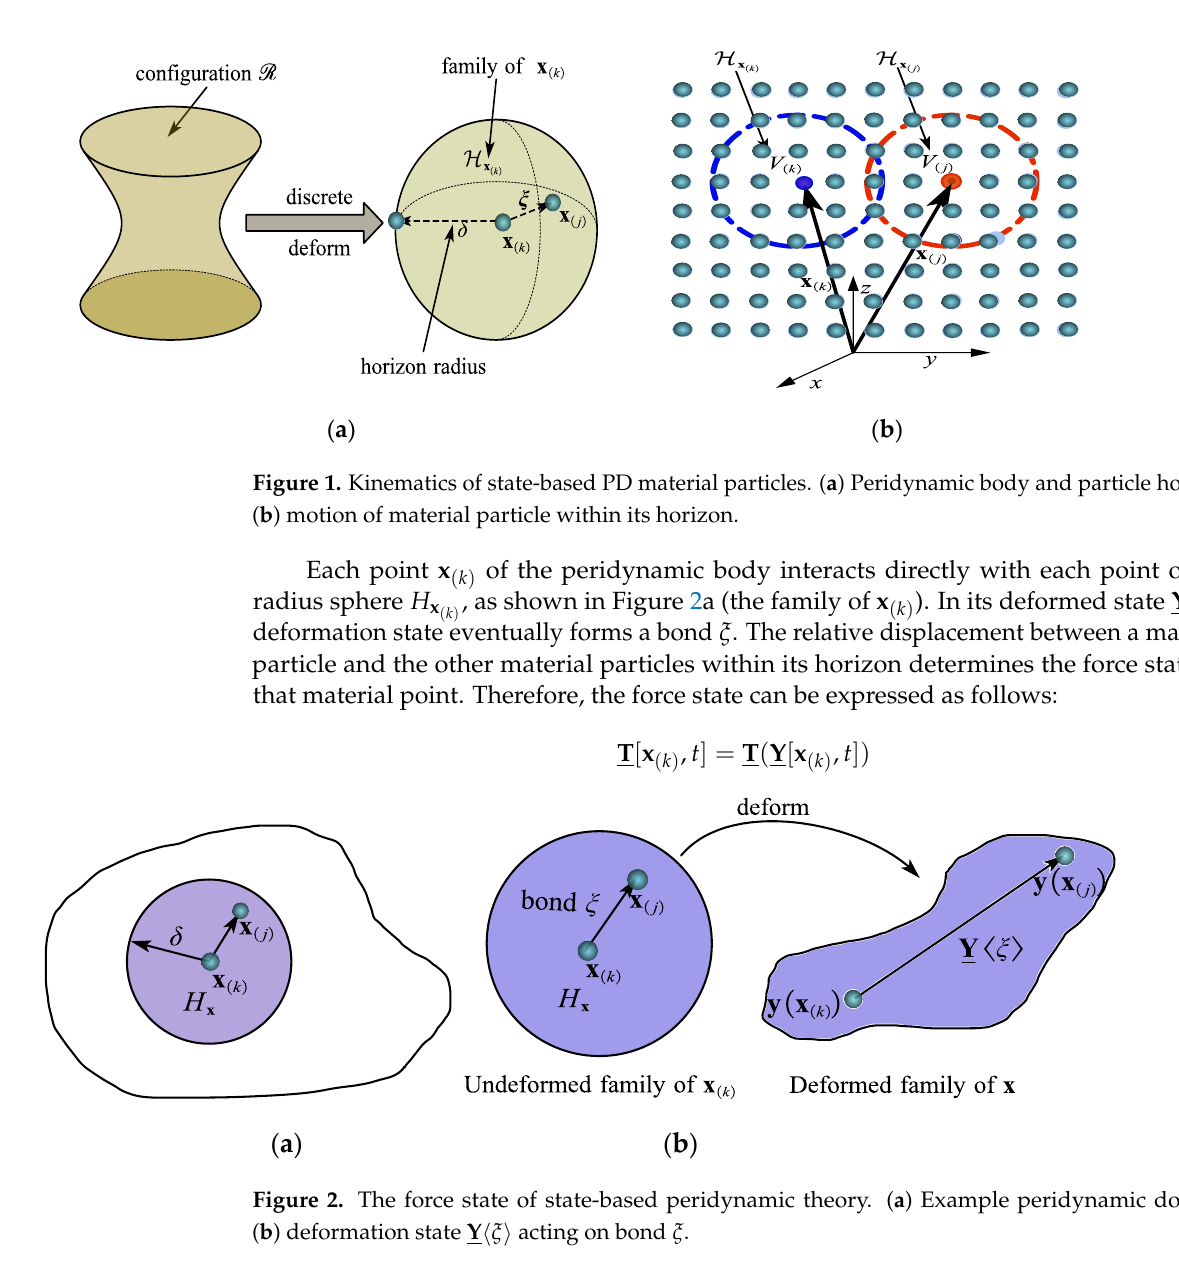
(cid:0) (cid:1) − y j = 1, 2, · · · , ∞ , y ( ( k ) k ) j )